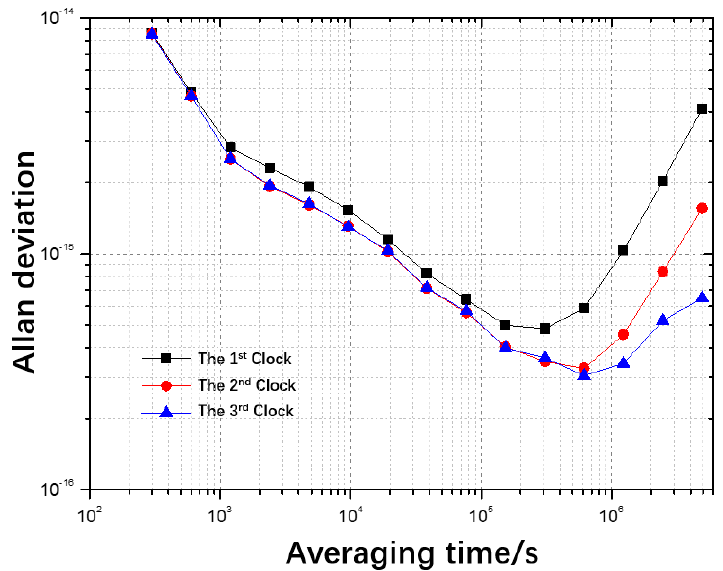
Figure 2. Allan deviation of three hydrogen masers with respect to UTC(NIM).